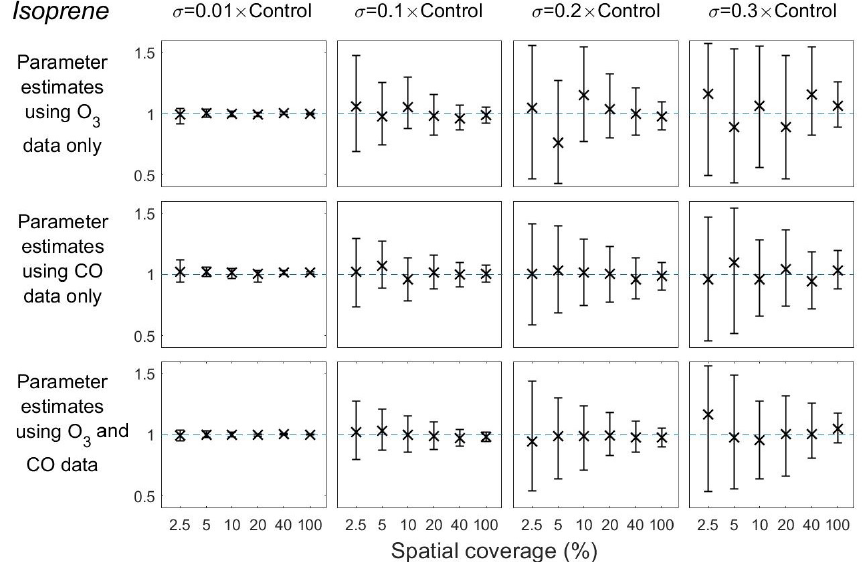
Figure 8. Means and 95% credible intervals of 3000 samples of the isoprene emission scaling parameter from posterior distributions using the MCMC algorithm based on synthetic datasets from scenarios 1–72 (Table 1). Control refers to the FRSGC/UCI model control run surface concentration for each output